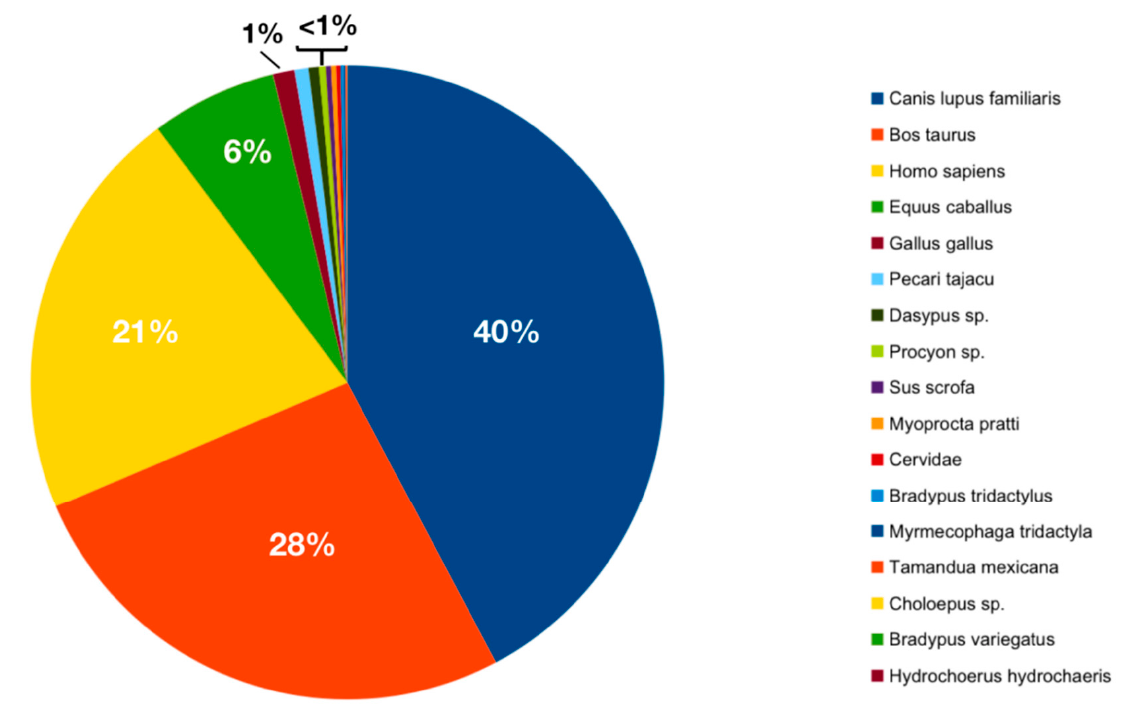
Figure 2. Pie chart representing the overall proportion of ingested blood from different hosts in all Mansonia specimens collected.